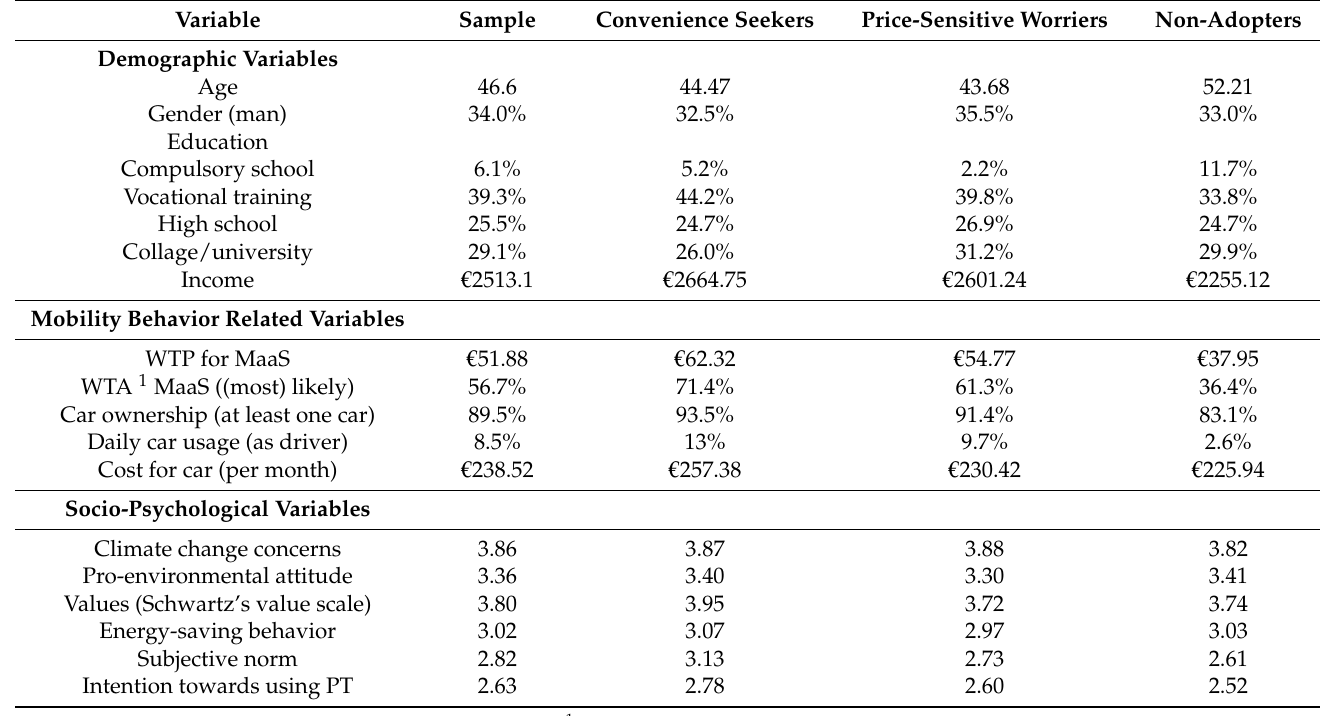
Table A1. Description of the sample and the